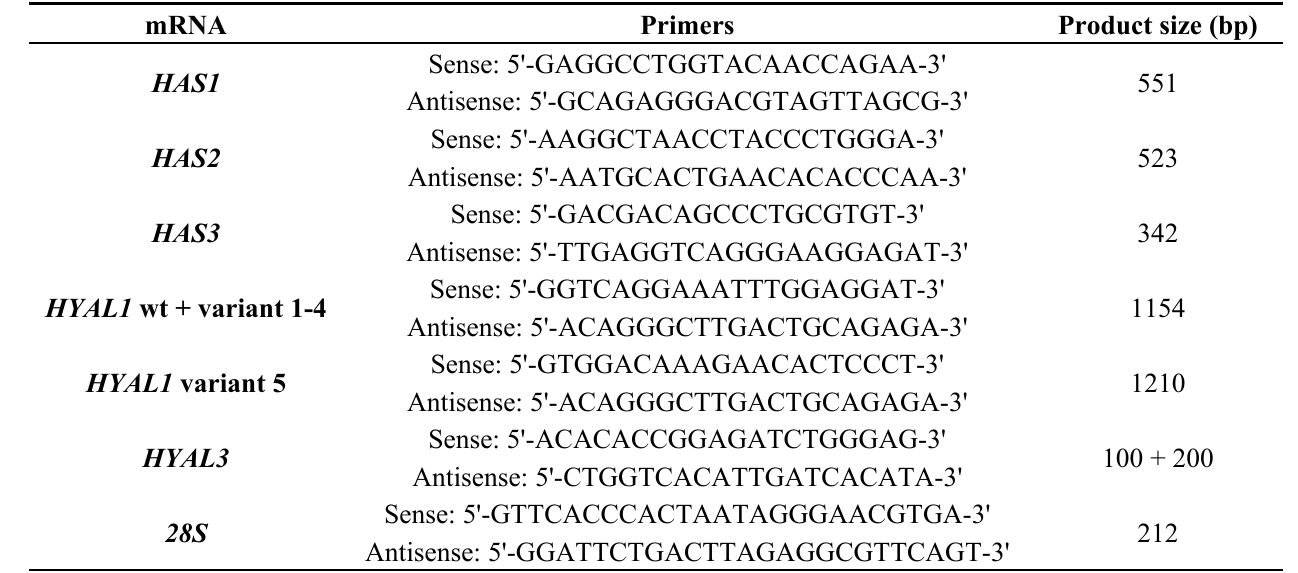
Table 3. Primers for